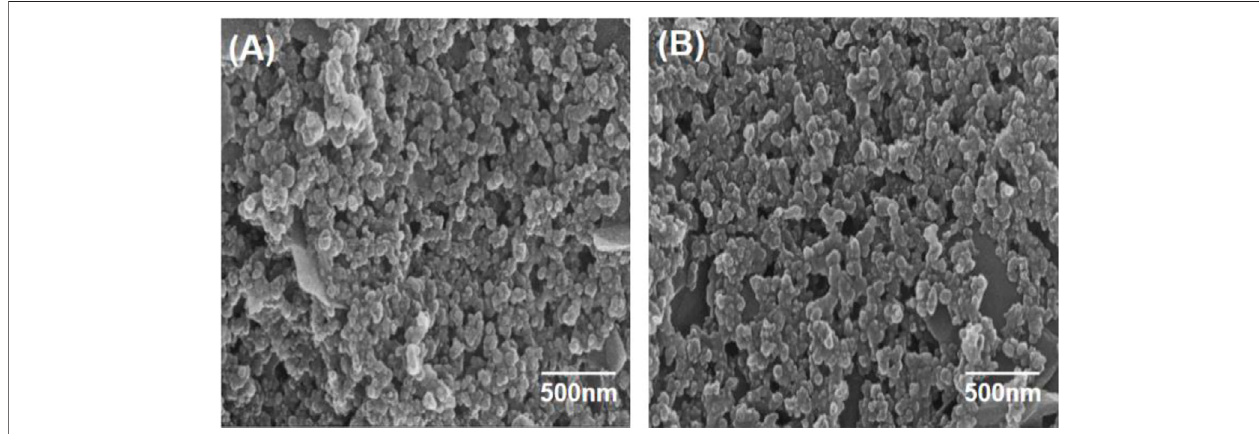
FIGURE2| AFMimage; (A) Bare/SPE (B) PDDA/SCPE (C) PDDA/P 2 W 18 POM/PEI-AgNPs/SCPEwithouterlayerPEI-AgNPs (D) PDDA/PEI-AgNPs/P 2 W 18 POM/ SCPE with outer layer of POM.